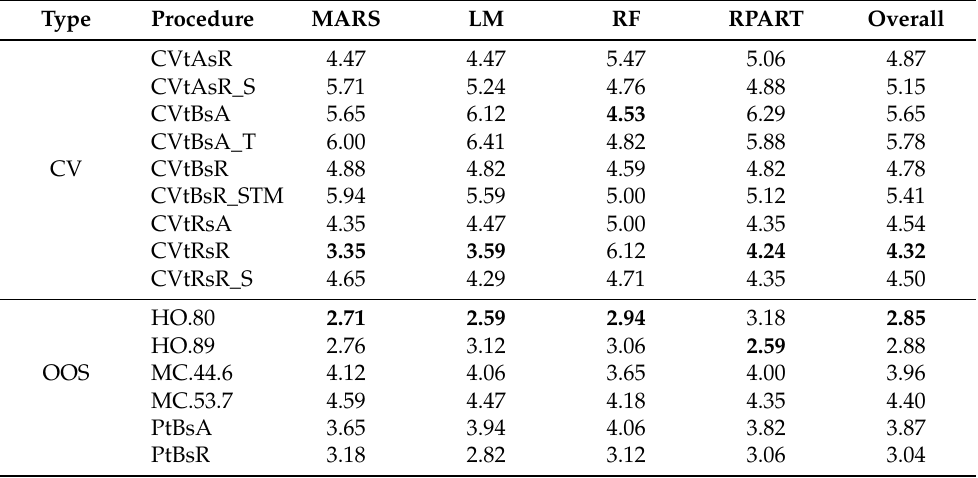
Table 5. Average ranks of absolute errors, calculated separately for cross-validation and out-of- sample procedures when estimating performance on 17 real-world datasets. The best results are in